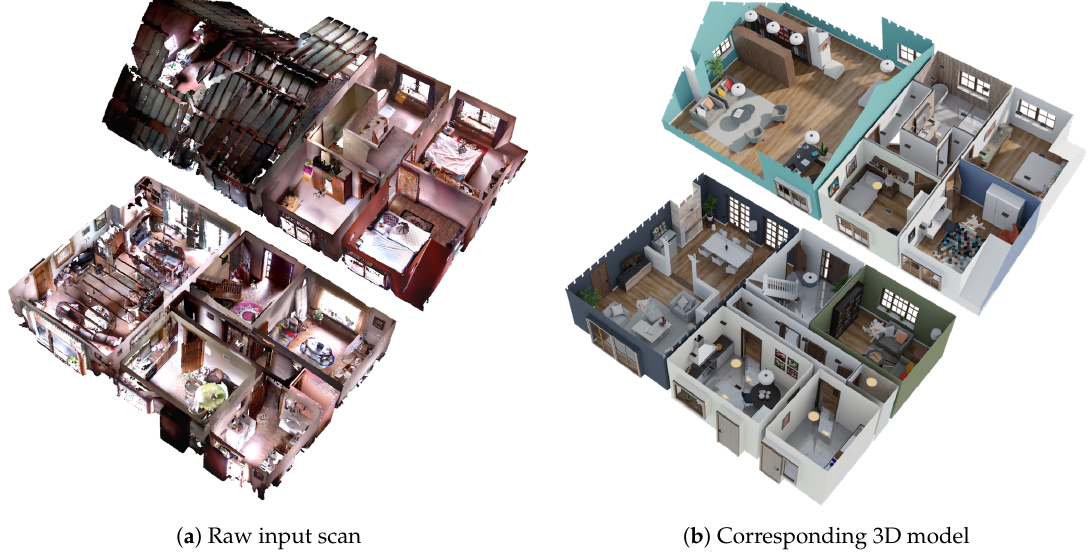
Figure 8. Example of a raw input scan together with the corresponding 3D model created by a Blender